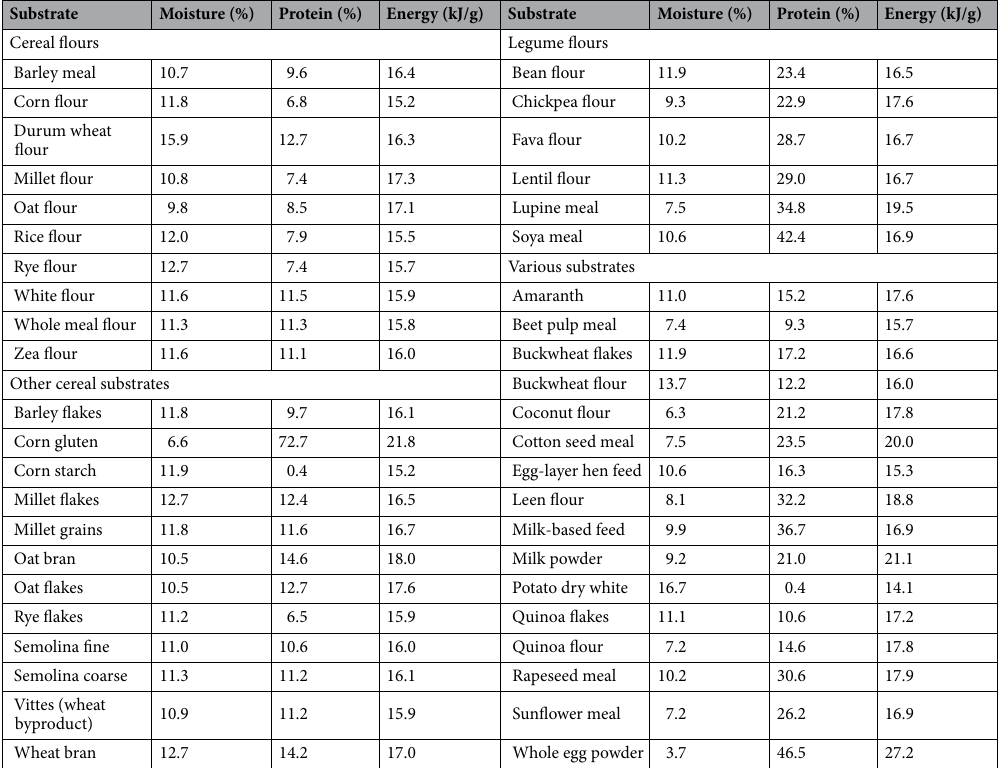
Table 1. Moisture (% as fed), crude protein (% as fed) and gross energy (kJ/g) of the commodities tested in the trials.